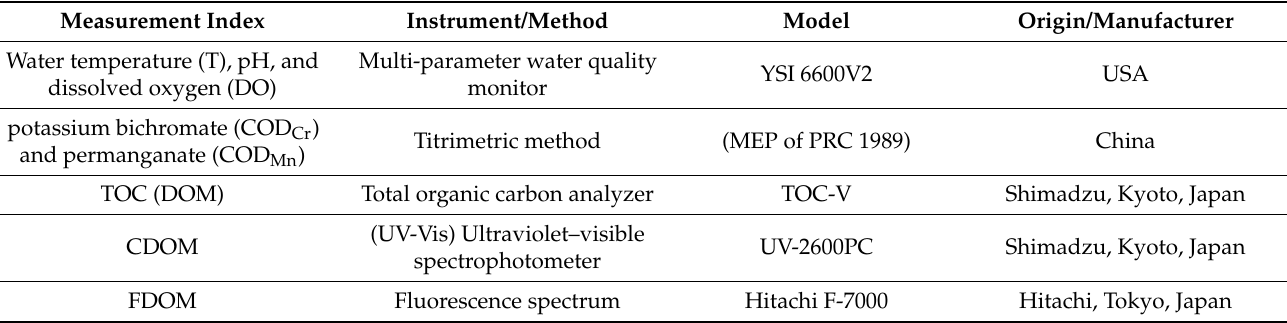
Table 1. Instruments used for the determination of the